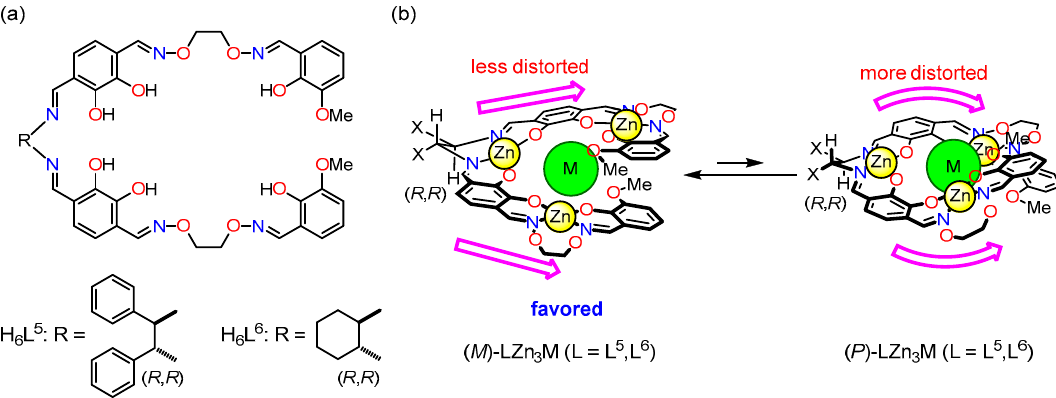
Figure 15. ( a ) Molecular structures of chiral ligands, H 6 L 5 and H 6 L 6 . ( b ) Concept of the predictable helicity control by using chiral salen unit (Category A in Figure 4).